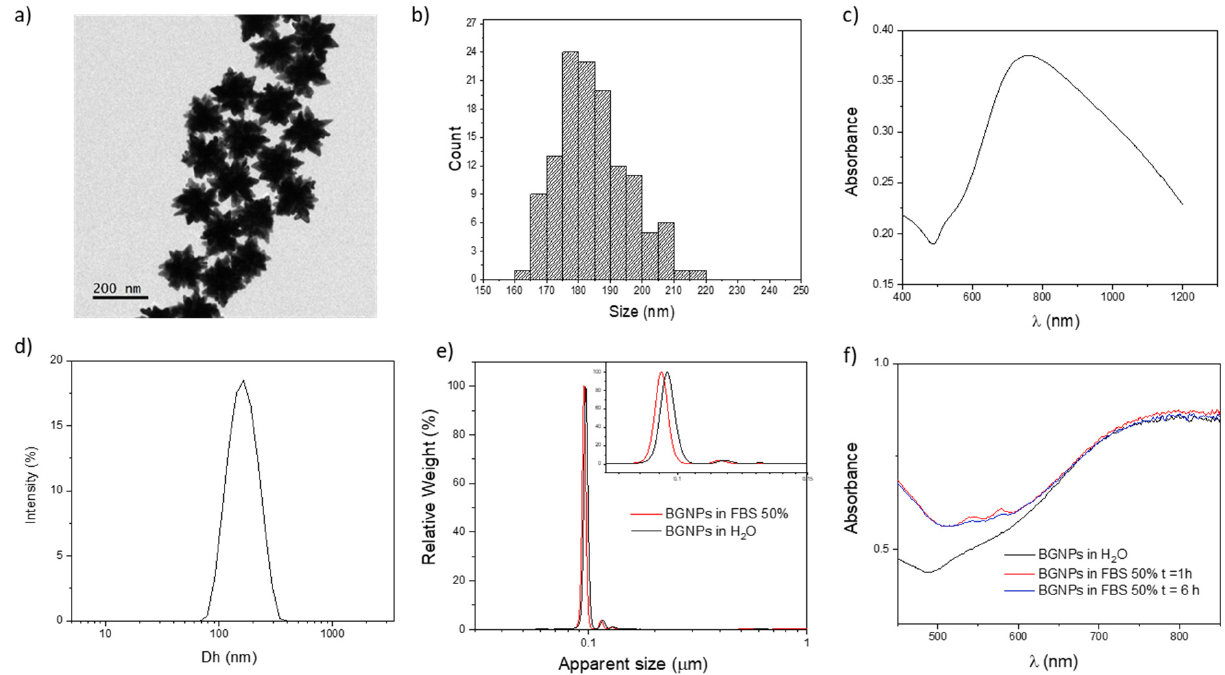
Figure 1. Characterization of BGNPs. ( a ) TEM micrograph. ( b ) TEM BGNP size distribution. ( c ) Vis–NIR absorption spectrum in H 2 O. ( d ) DLS analysis (Dh = 164 nm, PDI = 0.06). ( e ) DCS analysis of BGNP in H 2 O and cell culture media FBS 50% (apparent sizes of 100 nm and 97 nm respectively). ( f ) Absorption spectra related to the stability test of BGNPs in biological media: BGNPs were incubated in 50% FBS (in PBS) at 37 °C for different times (1 and 6 h). In the case of anisotropy, DLS and DCS do not represent the actual particle diameter. Consequently, representative particle distributions are reported rather than the actual sizes because of the incorrect geometrical assumption/approximation involved in the measurements.